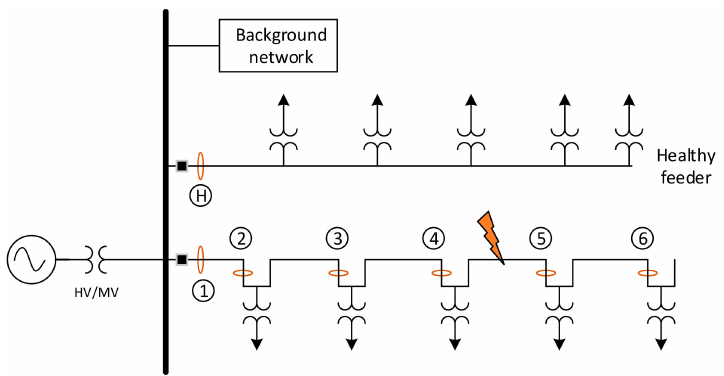
Figure 14. Urban isolated